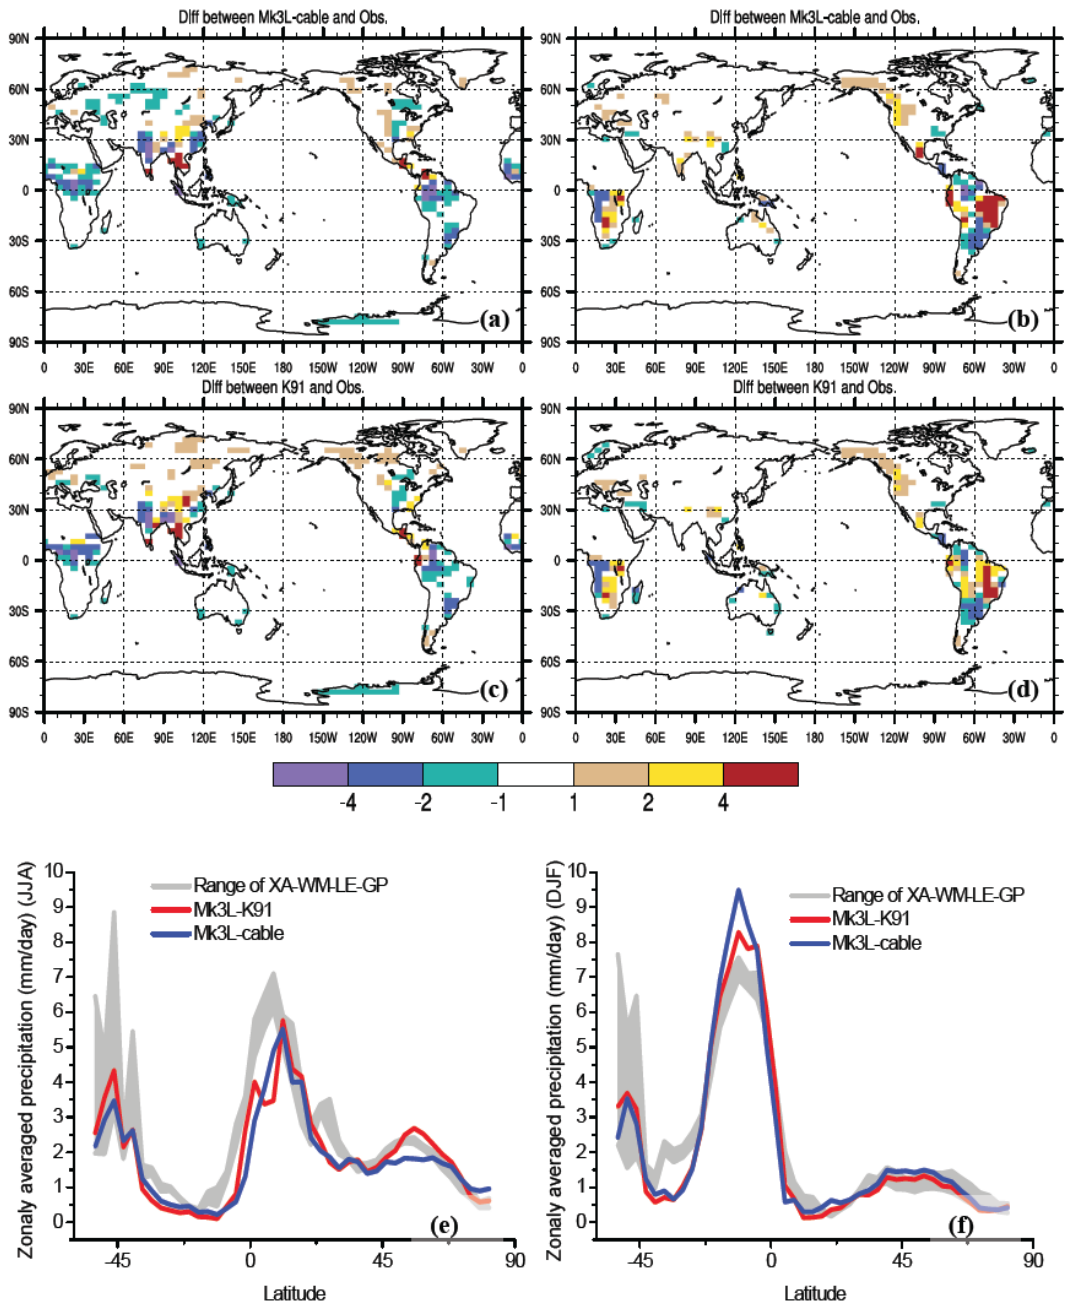
Fig. 4. As Fig. 3 but for precipitation (mmday − 1 ) differenced from the CMAP precipitation rate (Xie and Arkin, 1997). In the lower panels the observed range is shown for XA (Xie and Arkin, 1997), WM (Willmott and Matsuura, 2001), LE (Legates and Willmott, 1990) and GP (Huffman et al., 1997). Only values over continental surfaces are